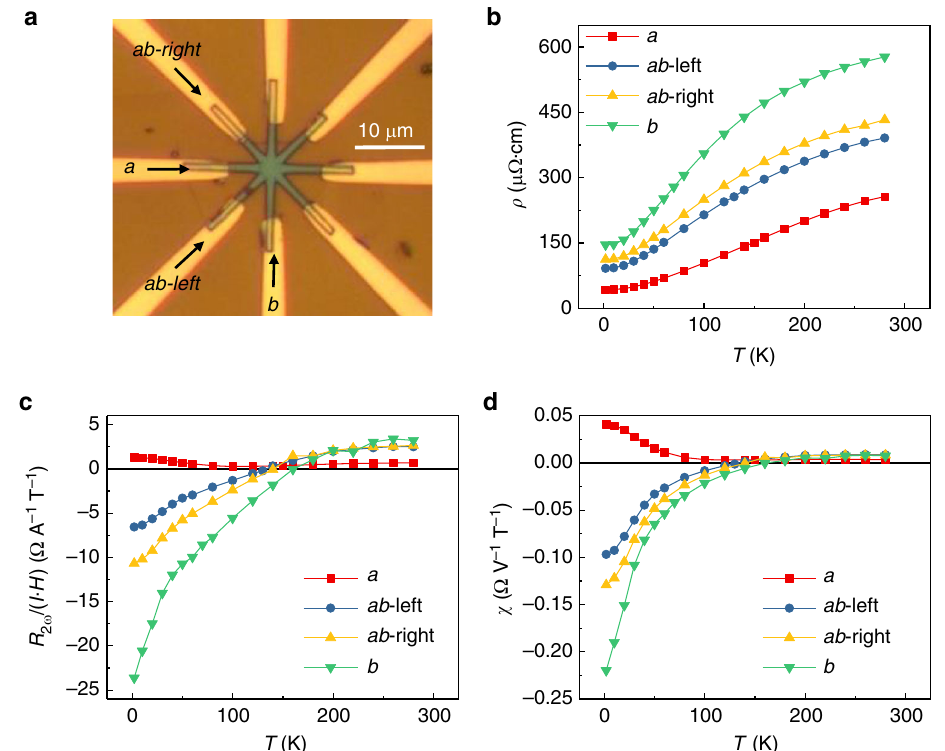
Fig. 3 Crystal anisotropy of nonlinear magnetoresistance. a Optical image of a circular Hall bar device with a fl ake thickness of 13.6 nm with arrows indicating the a and b directions. b Temperature dependence of the channel resistivity ρ along different crystallographic directions. c , d Temperature dependence of the nonlinear magnetoresistance R 2 ω (at φ = 270°) normalized under unit current and magnetic fi eld ( c ) and normalized under unit electric voltage and magnetic fi eld ( d ) along different crystallographic